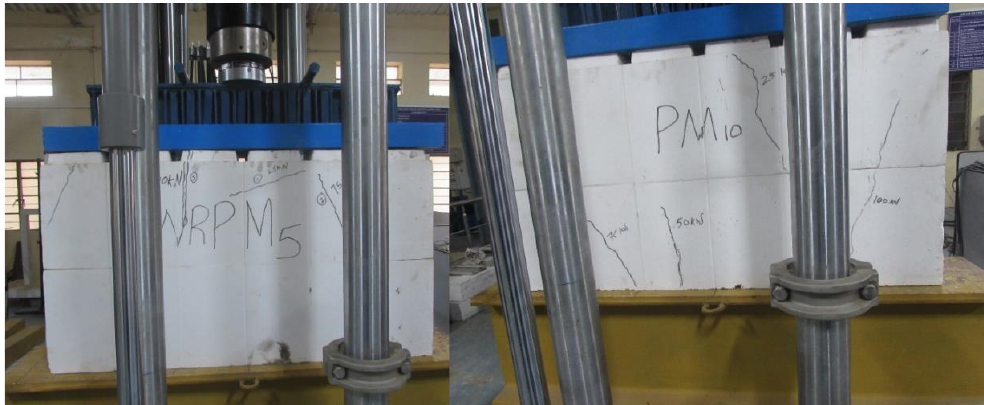
Figure 14. Failure caused while loading.